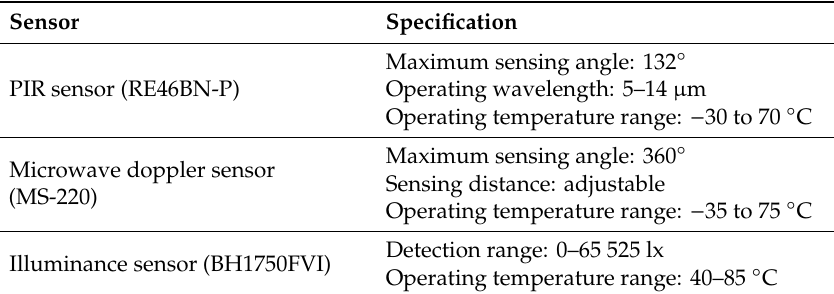
Table 1. Specifications of the sensors installed in the sensing module.